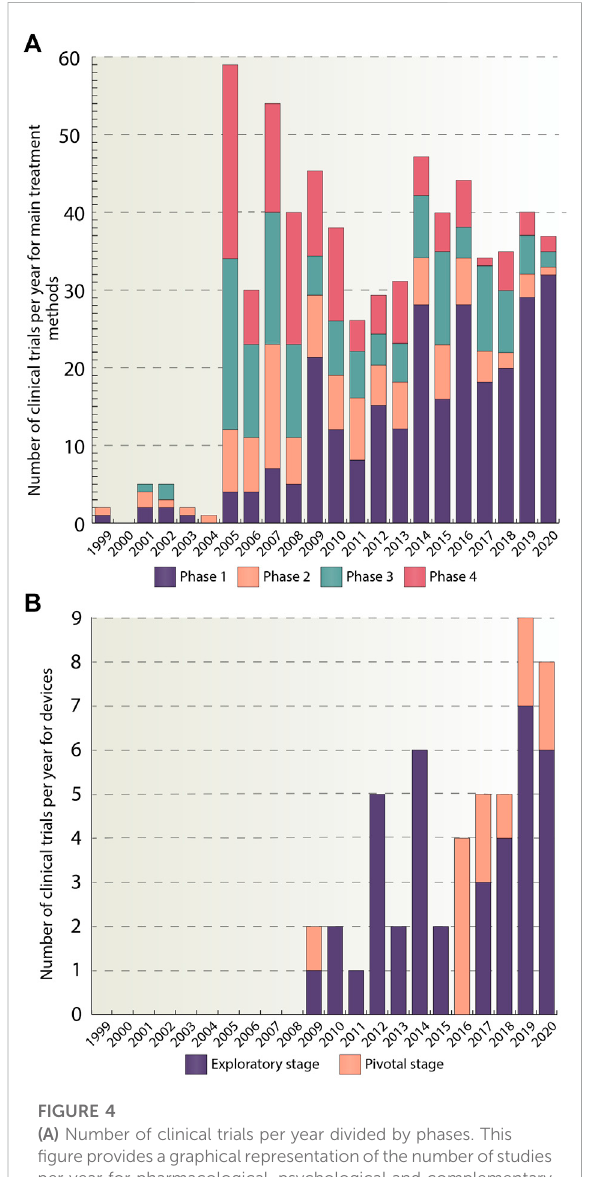
FIGURE 4 (A) Number of clinical trials per year divided by phases. This fi gureprovidesagraphicalrepresentationofthenumberofstudies per year for pharmacological, psychological and complementary and alternative methods, categorized by a trial phase for the whole analyzed period (1999 – 2020). In total, 644 studies were included in the analysis. (B) Number of clinical trials per year divided by stages. For devices, division by stages was used. Stages have been classi fi ed as follows: traditional feasibility, fi